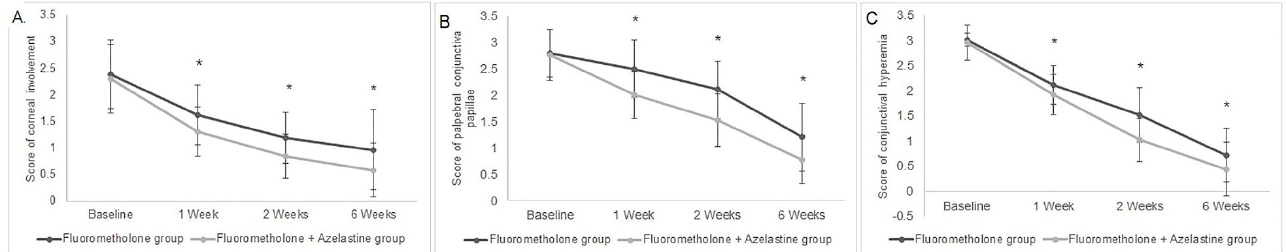
Figure 3. Improvement of corneal involvement, palpebral conjunctiva papillae and conjunctival hyperemia with 0.1% topical fluorometholone alone or combined with 0.05% azelastine from baseline. ( A ) The corneal involvement score was significantly decreased at all follow-ups in both groups ( p < 0.0001). A significant synergetic effect was found with combined topical 0.05% azelastine at 1, 2 and 6 weeks from baseline ( p = 0.0037, 0.0004 and 0.0069 at week 1, week 2 and week 6, respectively). ( B , C ) Combined treatment showed priority compared with isolated treatment at all visits in palpebral conjunctiva papillae and conjunctival hyper- emia (all p < 0.02). * p < 0.05 compared between group.